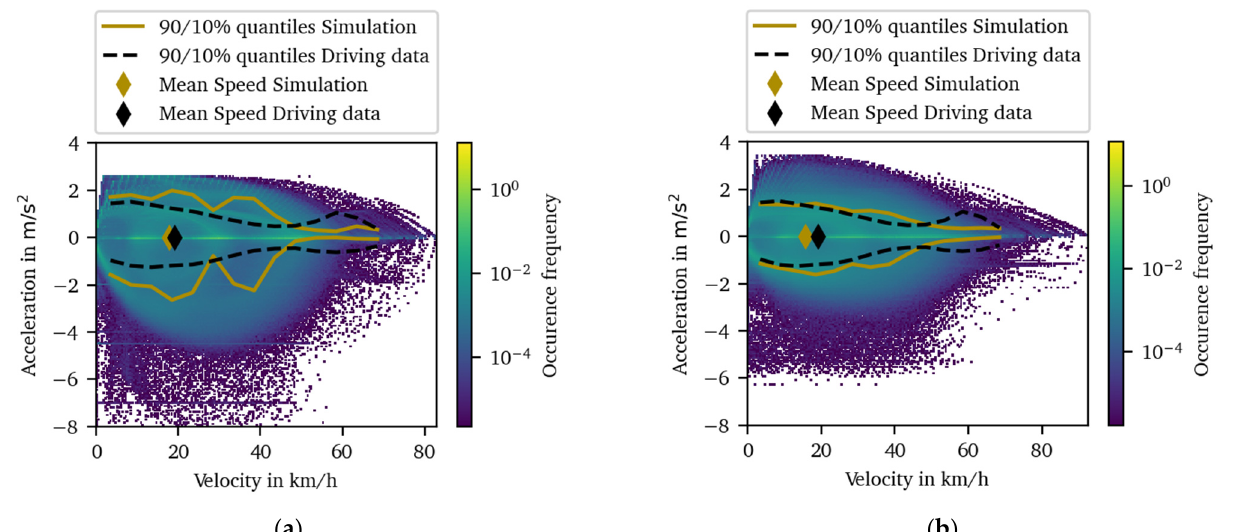
Figure 3. Aggregated driving profile of the simulated traffic fleet for ( a ) default model parameters and ( b ) optimized model parameters. The mean vehicle speeds of the simulated fleet and the measured driving data and the 90% and 10% quantiles of acceleration as a function of vehicle speed are highlighted.